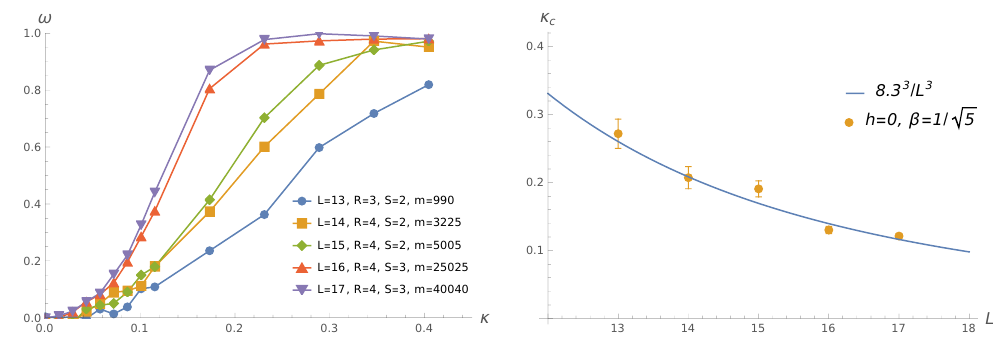
√ 5 , as κ varies from 0